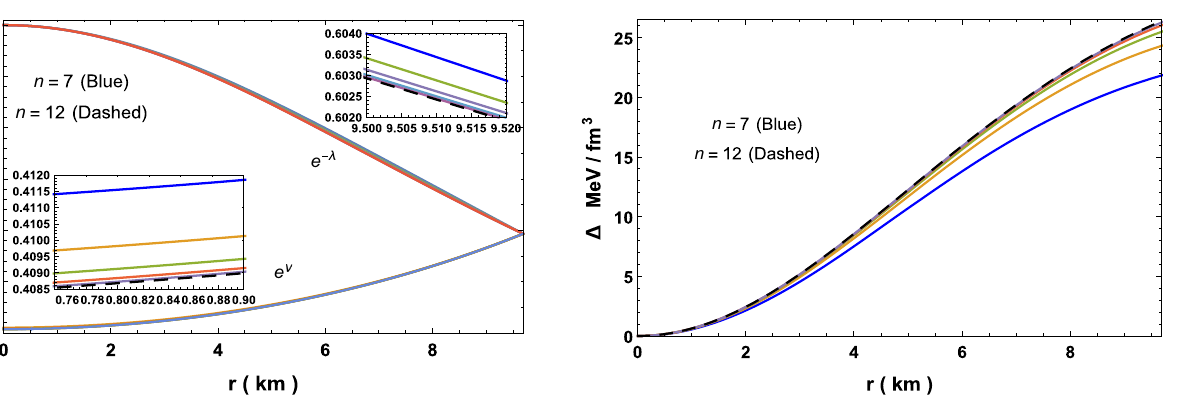
Fig. 1 Variation of metric potentials w.r.t radial coordinate r for M = 1 . 97 M (cid:6) , R = 9 . 69 km and b = 0 . 04